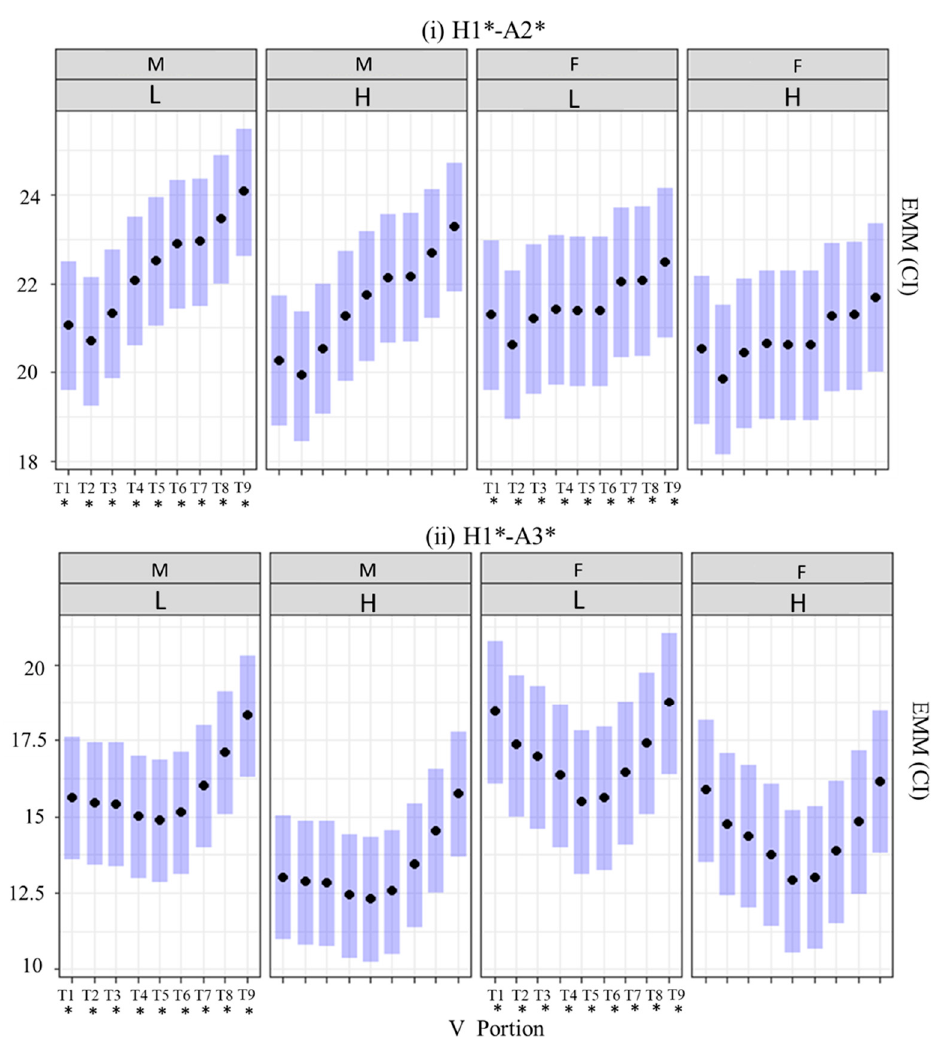
Figure 9. EMMs and confidence intervals (blue bars) of the nine timepoints of the vowels carrying contrastive tones (viz., low and high, indicated as L and H) derived from ( i ) H1*–A2* and ( ii ) H1*–A3* for male (M) and female (F) speakers separately. The asterisk (*) at each timepoint indicates the significance level of pairwise comparisons between the timepoint.